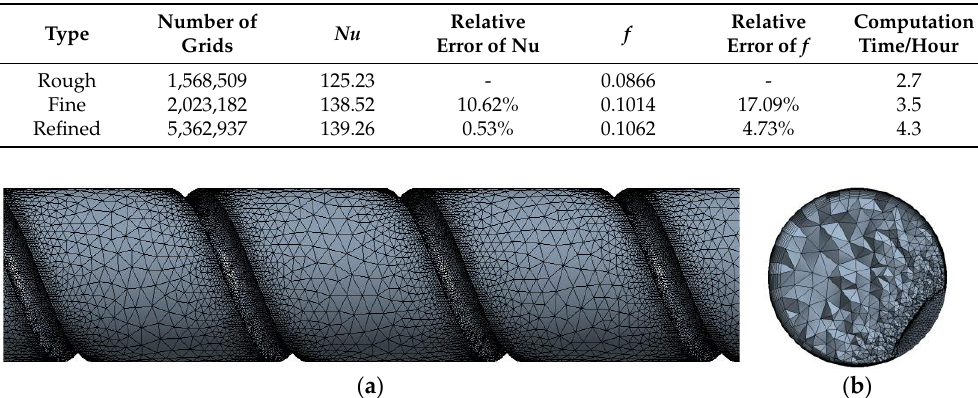
Figure 3. Schematic diagram of grid distribution for pipe 4#: ( a ) global view, ( b ) section